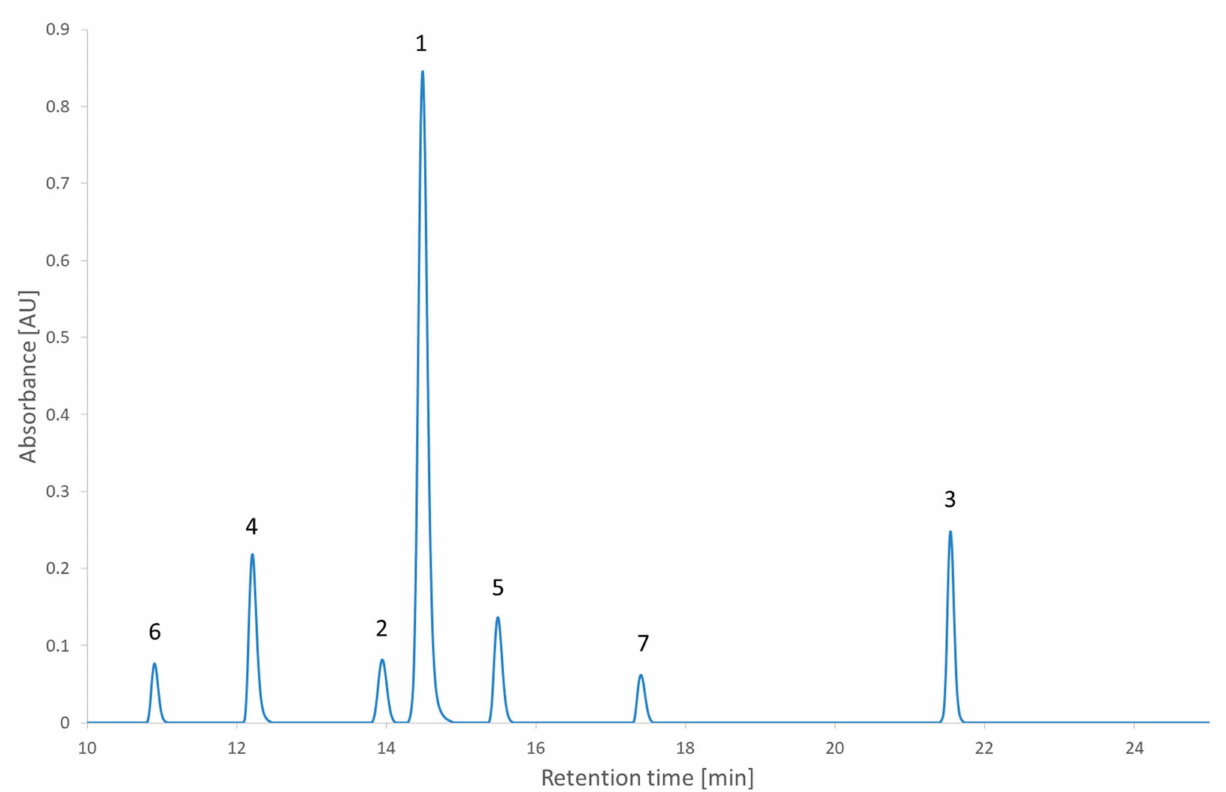
Figure 8. The chromatogram extracted at 210 nm of the second test set analyzed in the condition of pH 4.2 and a gradient time of 20 min. 1: 2,2 (cid:48) -bipyridine, 2: 4-nitrophenol, 3: ibuprofen, 4: